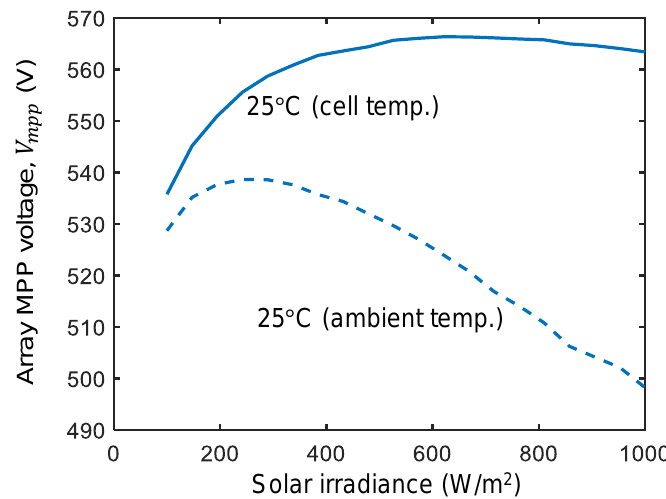
Figure 3. Variation of MPP voltage for variation of